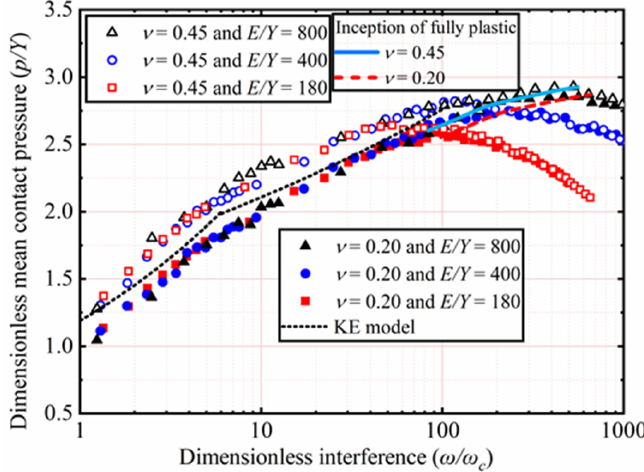
Figure 10. p/Y as a function of ω/ω c for different E and ν .